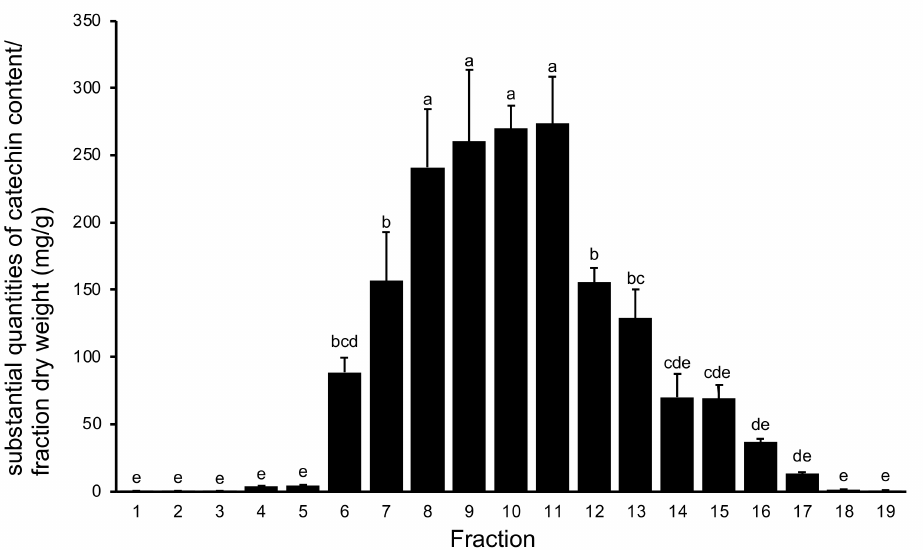
Figure 2. Proanthocyanidin content of fractions from water extracts of V. virgatum stems. Data are mean ± SD for three independent experiments. Different letters represent significant differences by Tukey’s multiple comparison test ( p =